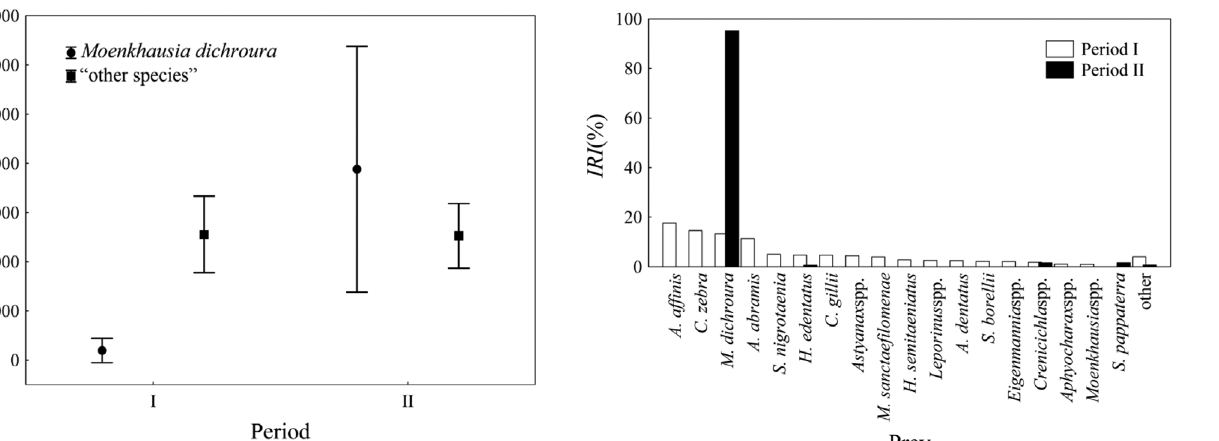
Fig. 2. Abundance of Moenkhausia dichroura and “other species” in the period I (From March 2000 to February 2001) and II (From March 2003 to February 2004), after impound- ment of Manso River, Mato Grosso State, Brazil. Vertical bars represents the mean ± S.D.